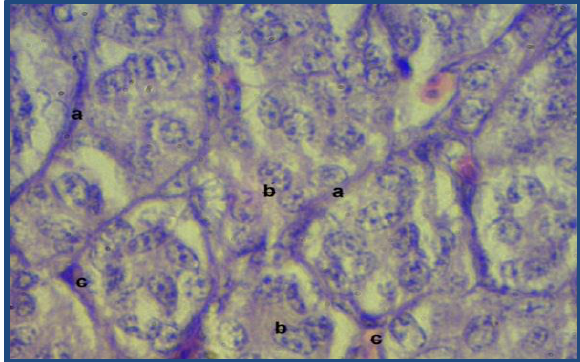
Figure, 10: Parathyroid gland showed: a- connective tissue sheath b- Chief cells c- Thin septa (H and E stain, 100 X).